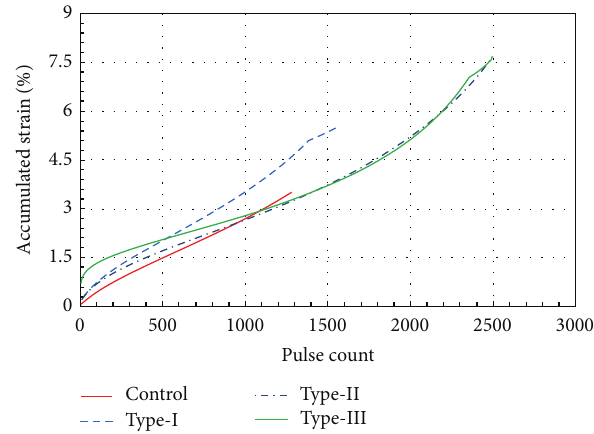
Figure 9: Variation in accumulated strain with respect to rubber type and pulse count.